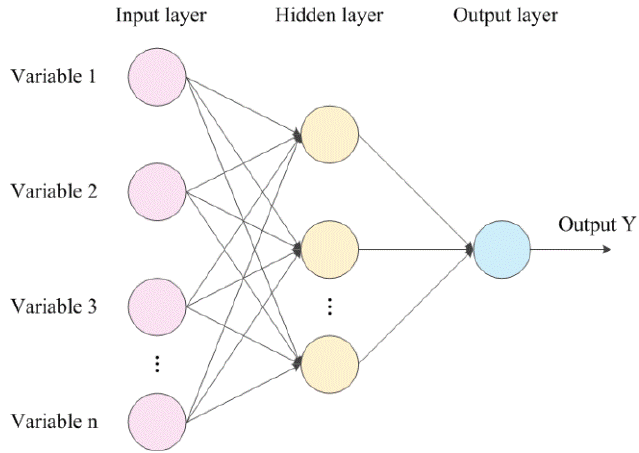
Figure 6. An example of an MLP network with one hidden layer.